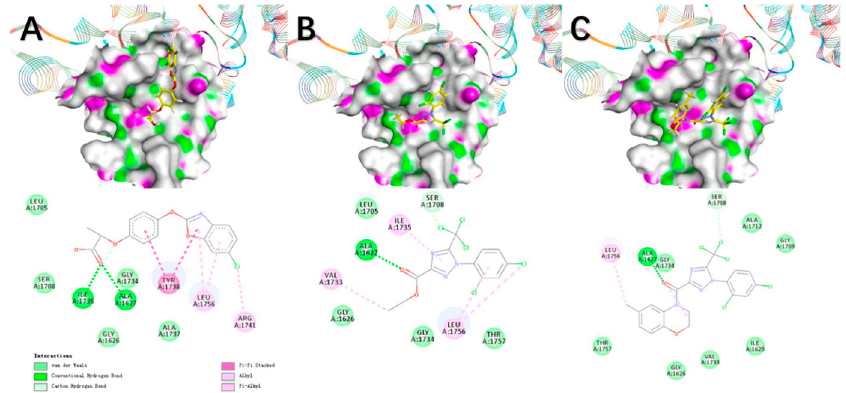
Figure 3. The docking modeling of herbicide fenoxaprop acid ( A ), safener fenchlorazole ( B ) and